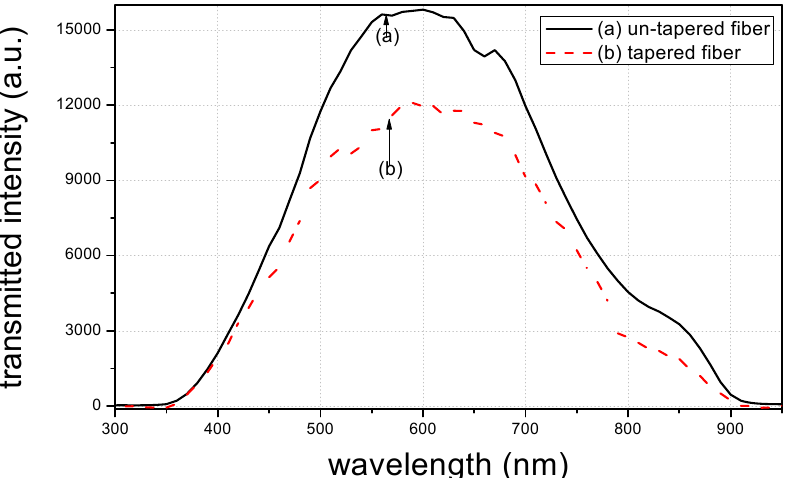
Figure 7. transmittance of tapered fiber and un-tapered fiber.